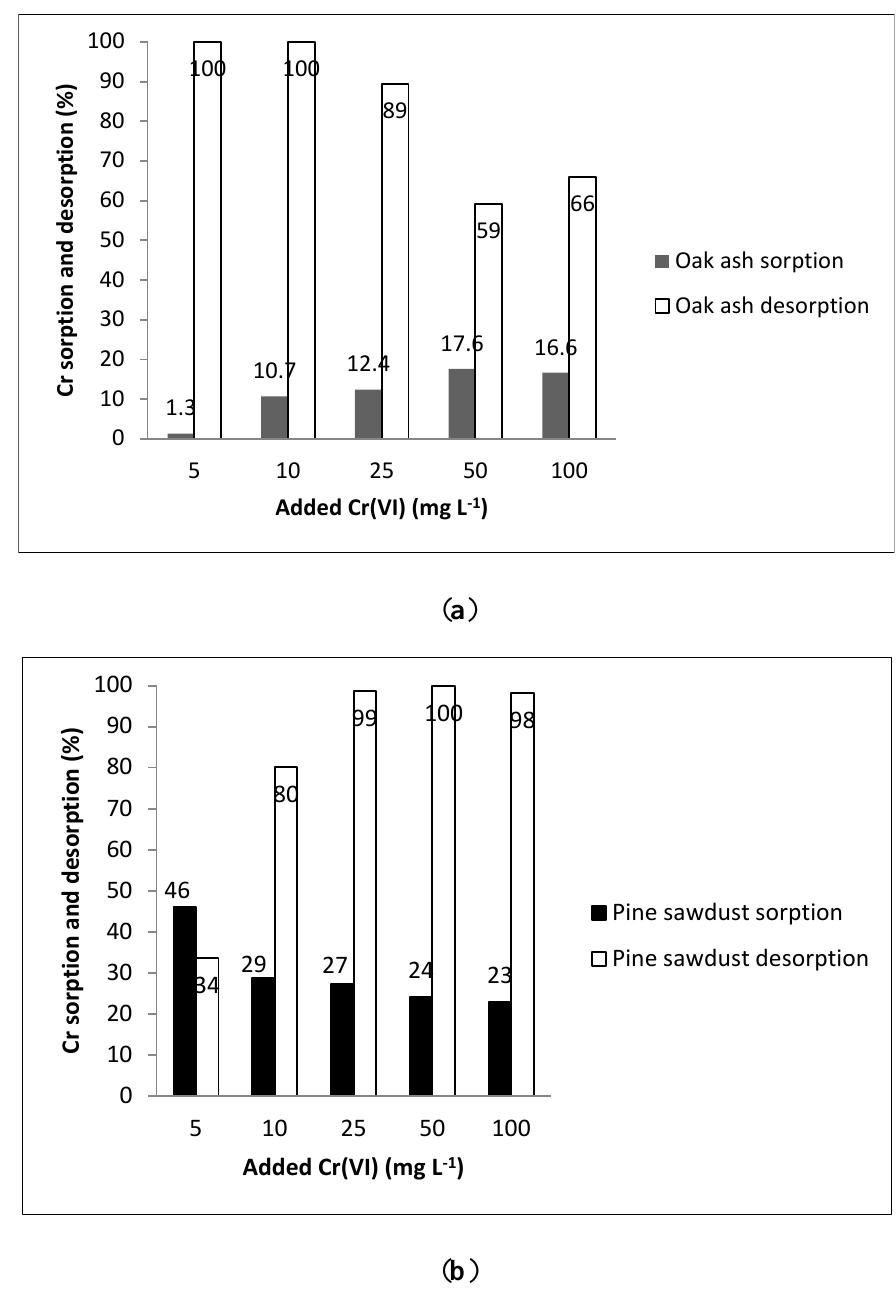
Figure 2. Sorption and desorption percentages corresponding to increasing Cr(VI) concentrations added to oak wood ash ( a ) or to pine sawdust ( b